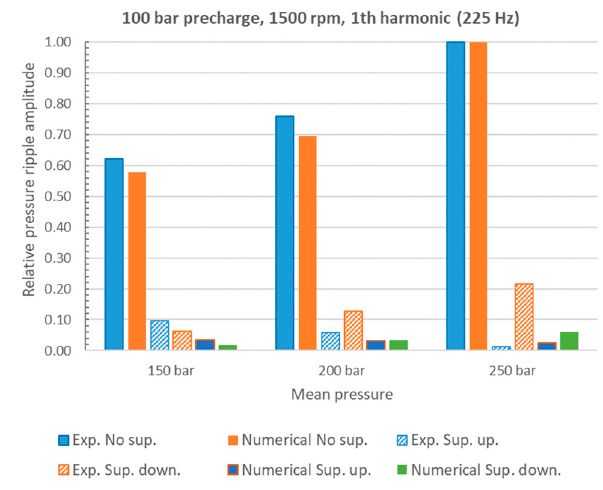
Figure 14. FFT of the pressure ripple, 2nd harmonic, pump speed = 500 rpm.